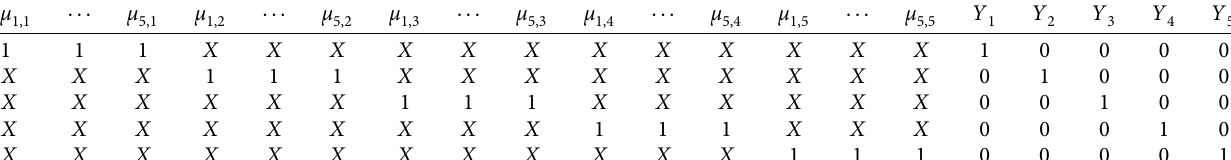
Table 1: Rules associated with the structure of the neuro-fuzzy system are used for